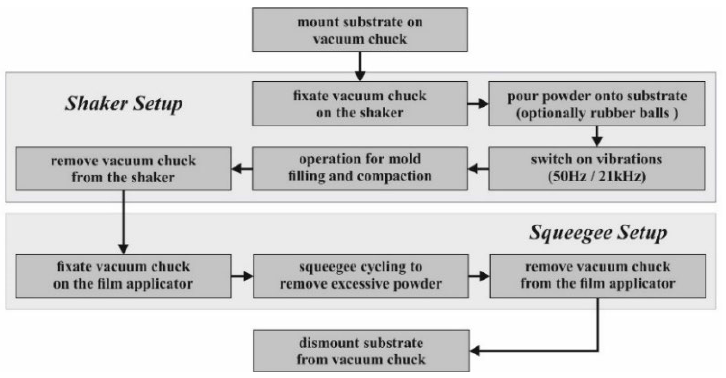
Figure 12. Schematic workflow of the automated mold filling procedure as described in this work.